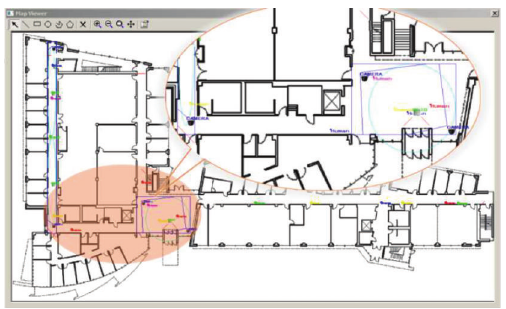
Figure 11: The snapshot of the proposed system during simulation of body detection